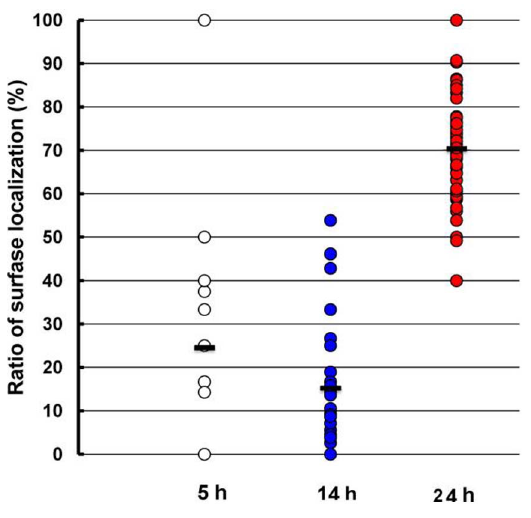
Figure 6. Degradation of hydrogen peroxide in cell suspension of E . oxidotolerans T-2-2 T and that in 0.1% Tween 60-treated cell suspension. The untreated cells and 0.1% Tween 60-treated cells are indicated by open circles and filled circles, respectively. The cells were obtained after 36 h of cultivation. The amount of the cells was adjusted as OD 650 =0.005 in the final reaction mixture. The reaction was performed at 25 u C.